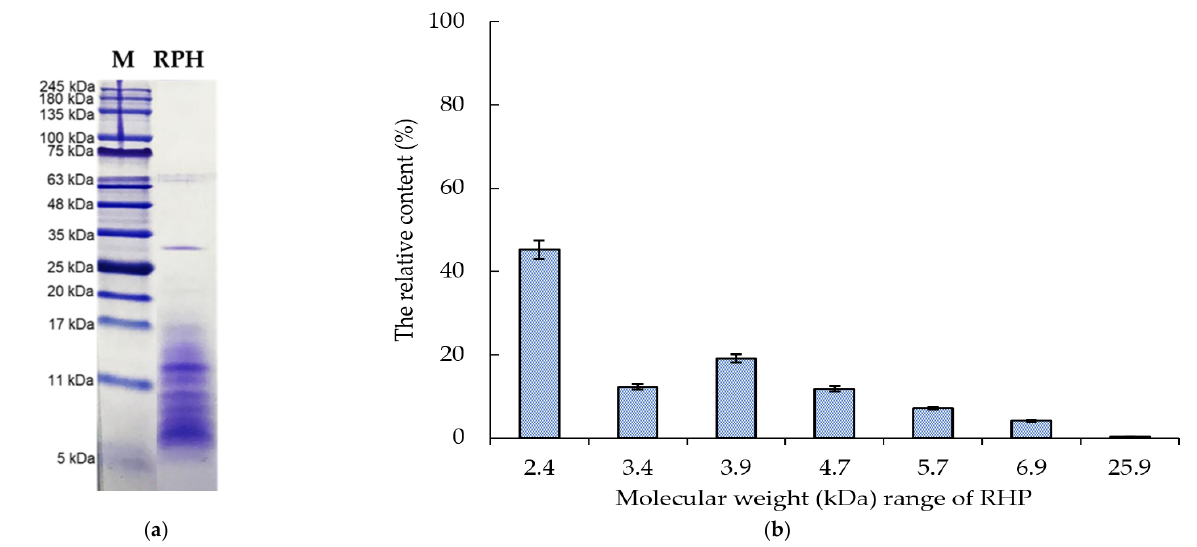
Figure 8. Molecular weight (MW) determination for RPHs through sodium dodecyl sulfate–polyacrylamide gel electrophoresis (SDS-PAGE): ( a ) tricine-SDS-PAGE patterns of the MW marker (line 1) and RPHs (line 2) and ( b ) the relative content (%) of each MW of RPHs.